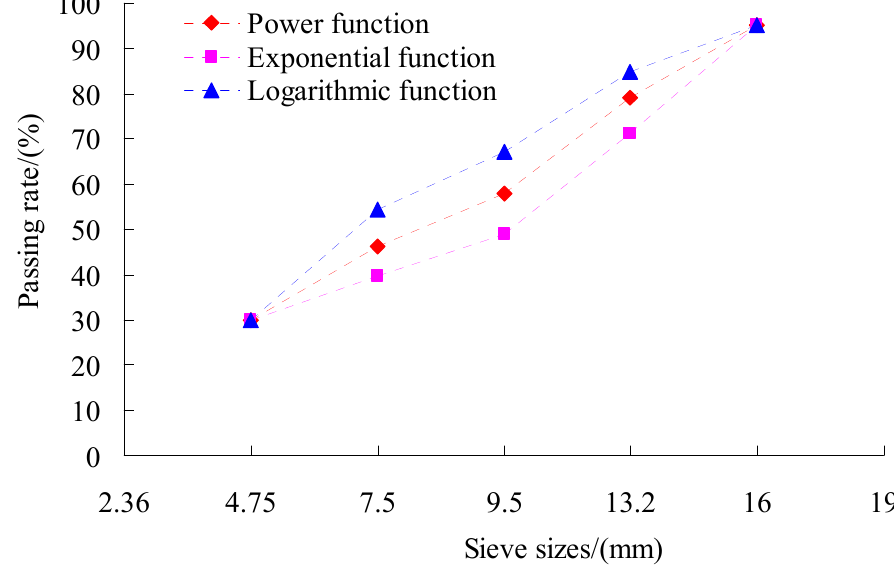
Figure 1. Three trial coarse aggregate gradations. VCA DRC can be used as the standard of criteria of skeleton formation of asphalt mixture [34]. It can be seen from Figure 2 that the VCA DRC of the gradation of logarithmic function and exponential function were the largest and the smallest, respectively, and the VCA DRC of the gradation of power function was in the middle of them. Considering the performance balance of the asphalt mixture, the gradation of power function should be selected at